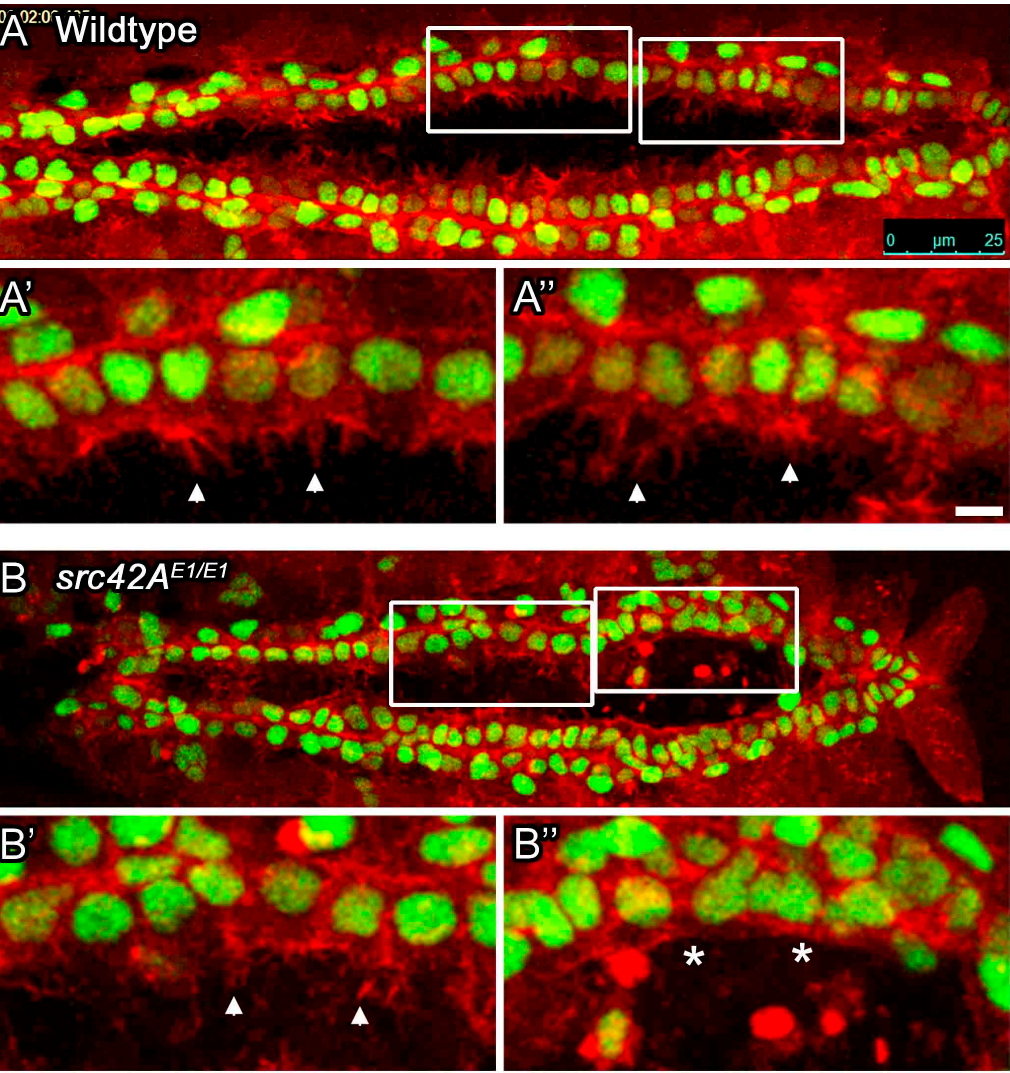
Figure 3. In src42A mutant embryos, cardioblasts with stalled migration lack leading edge membrane activity . The dynamic activity of the leading edge of migrating CBs was monitored in living embryos. Membrane actin was labeled with dMEF-GAL4 regulated UAS-moesin-mCherry (red), while CBs were marked with tup-GFP (green). In wildtype embryos ( A ), both the anterior and posterior CBs extend highly dynamic processes towards the midline (arrowheads in A’ and A’’ ). In src42A E1 mutants, anterior CBs extend processes towards the midline (arrowhead in B’ , cross-section in C ), but posterior CBs remain rounded ( C’ ) and do not extend such processes (asterisks in B’’ , C’ ). Posterior of the heart is to the right ( A , B ); dorsal at top ( C , C’ ). Calibration: 25 microns in A and B, 5 microns in all other panels.